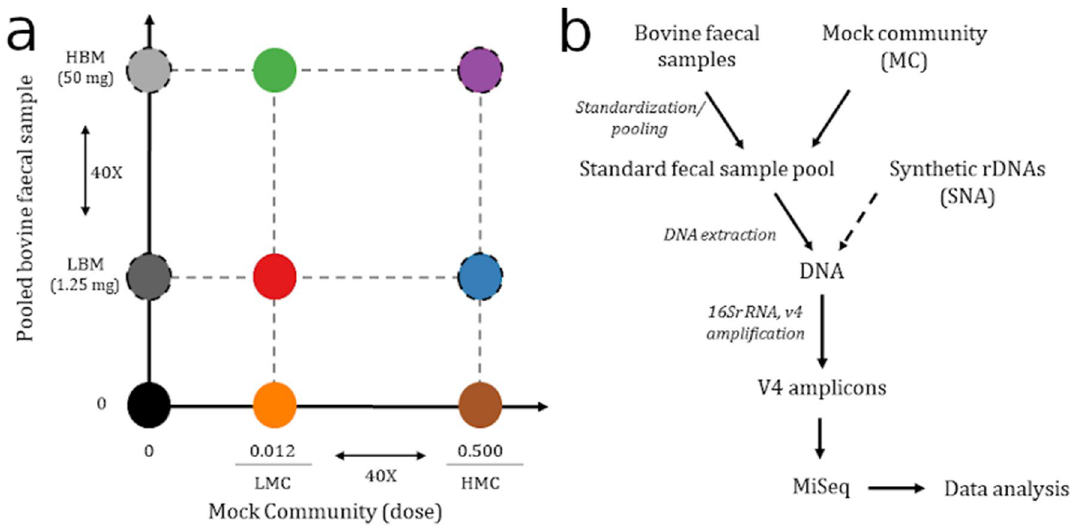
Figure 1. Experimental design. ( a ) combinations of mock community and pooled bovine fecal samples considered in the study. Each combination is marked with a different color. Colors reported in this figure match those used in the manuscript Figures. The black circle outline indicates the inclusion of synthetic 16S rDNA molecules (SNA) as PCR spike-ins. ( b ) schematic representation of the main methodological steps performed in this study. Briefly, bovine fecal samples were pooled into standardized fecal pools. Sample pools were supplemented with the mock community before DNA extraction. Synthetic rDNA molecules were added to DNA samples before PCR amplification. Libraries were sequenced on paired-end runs (2 × 250 bp), using an Illumina MiSeq sequencer. Data analyses included quality processing, generation of SVs and statistical analysis of sequencing